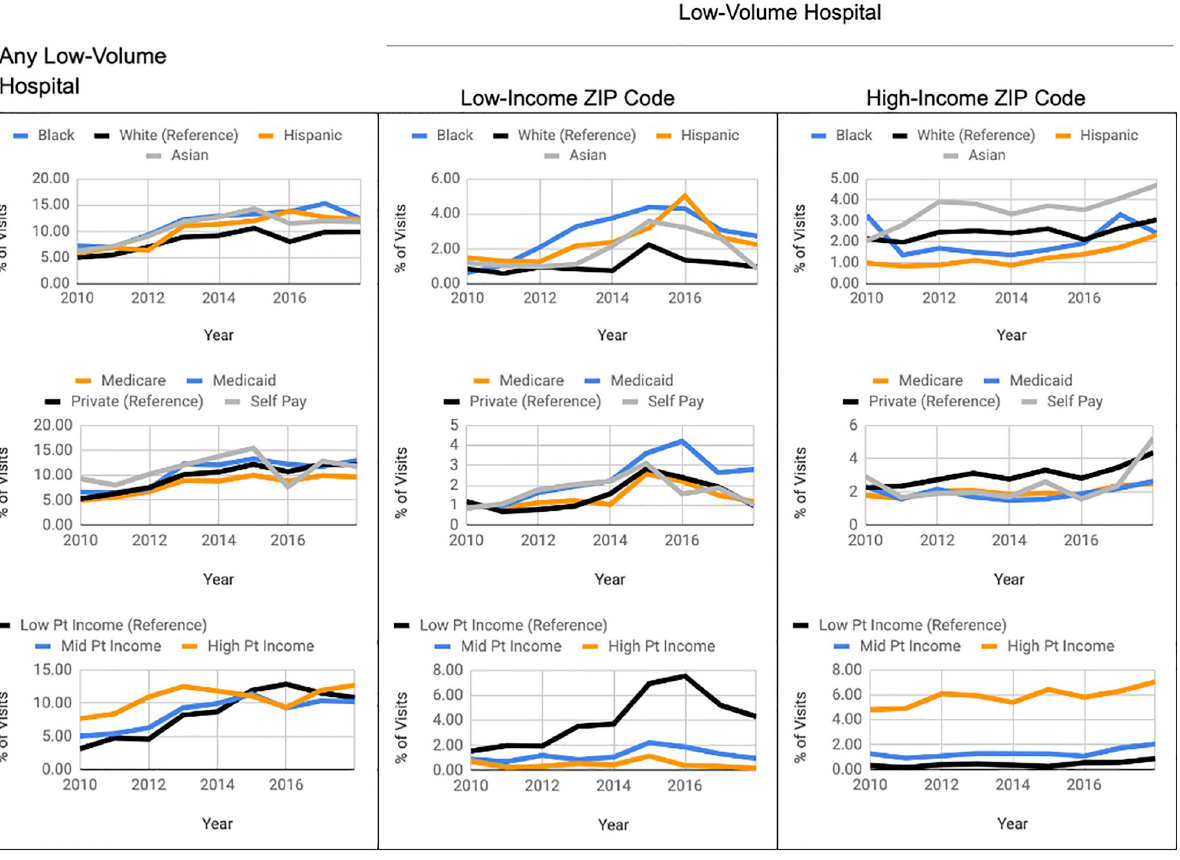
Fig 2. Unadjusted likelihood of receiving PCI at hospitals by volume and income status.